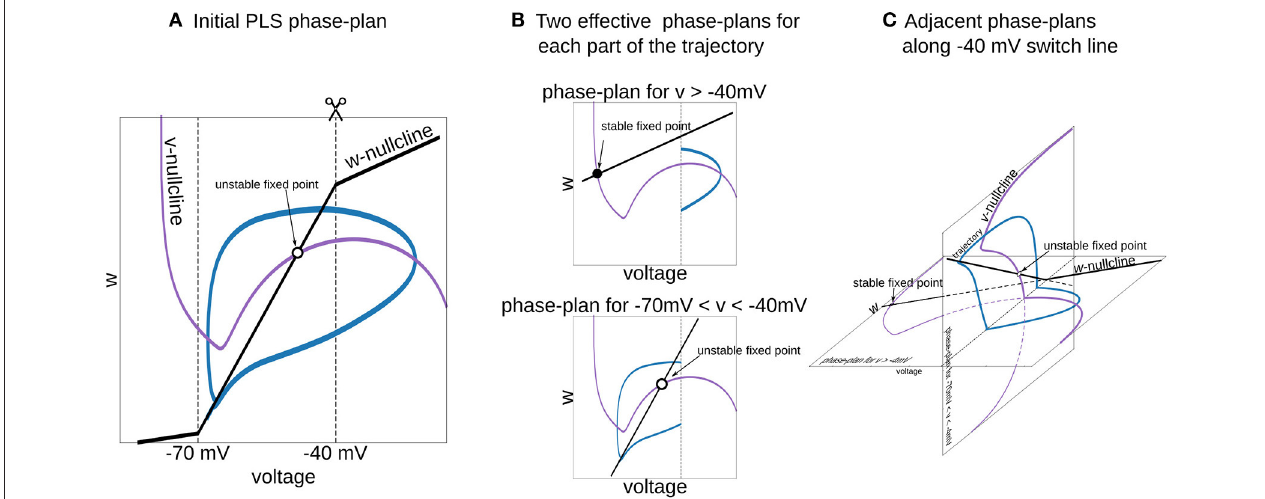
FIGURE 6 | Interpretation of piecewise-Linear w -nullcline as a trajectory jumps between two phase-plans with pure linear w -nullclines. (A) The phase-plan of PLS model, similar to Figure 1C . Note that trajectory goes through two voltage ranges, where w -nullcline has different slopes. (B) Two phase-plans for each voltage range. The trajectory jumps from one phase-plan to another then crosses − 40 mV line (C) Visualization of this two phase-plans as an adjacent spaces which intersect along − 40 mV switching line. Horizontal phase-plan corresponds to the system when the voltage is higher than − 40 mV and a vertical phase-plan for voltages between − 70 and − 40 mV. Similarly, for the PL2D reduction of the Wang and Buzsáki model ( Figure 1 ), two phase-plans are v - n